Question: What kind of plot is shown here?
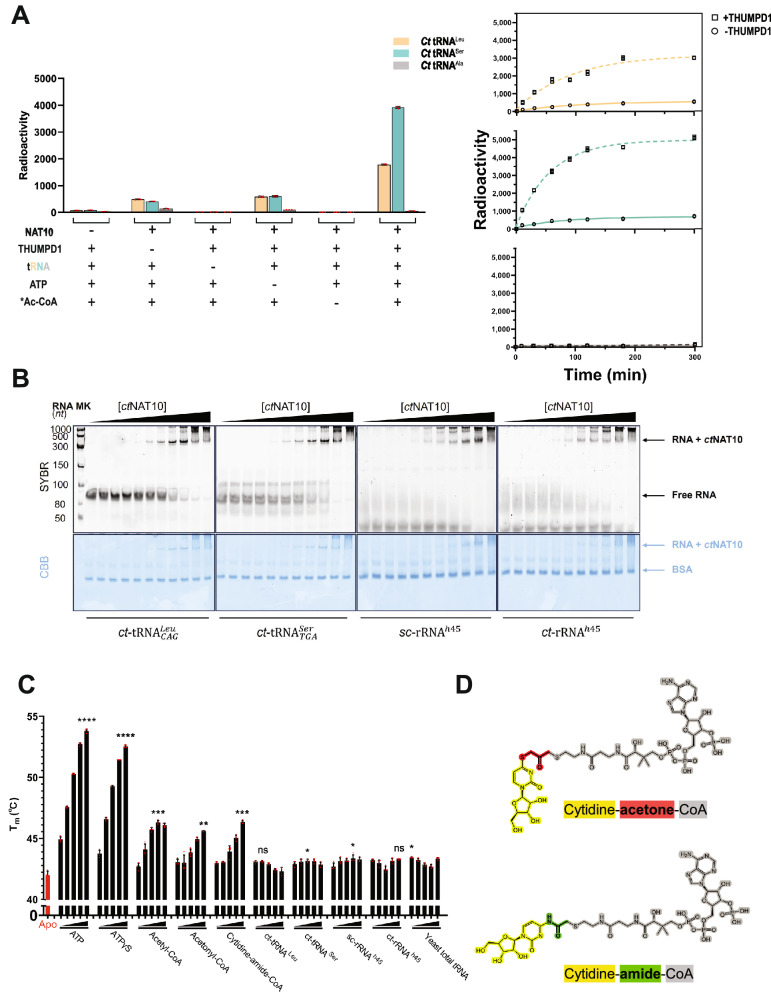
Answer: line